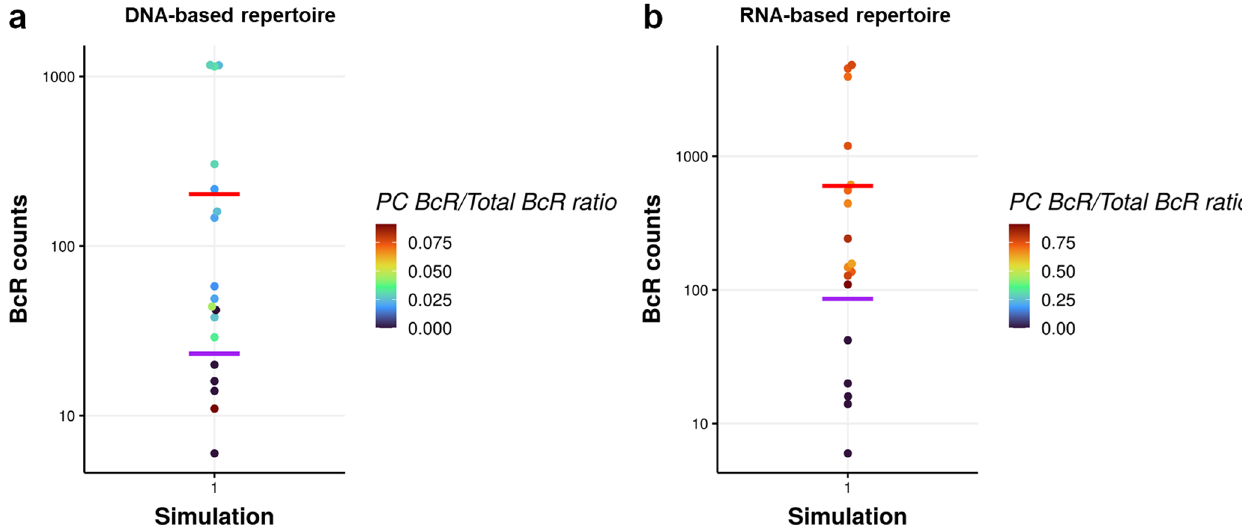
Fig. 9 Beeswarm plots in log10 scale of DNA-seq and RNA repertoires. Beeswarm plots in log10 scale of ( a ) DNA-seq and ( b ) RNA repertoires at day 21 of the GC reaction generated by a representative simulation. Each dot represents a clone, some of which are a mixture of B cells, MBCs and/or PCs. In both cases, we fi nd 5 and 13 dominant clones using the 75th percentile or 0.5% threshold, respectively. Dot colors indicate the fraction of PC BcR sequences within each clone, whose range is about a factor of 100 times larger for the RNA-based repertoire. The size of the symbol represents the median af fi nity of that clone (small symbol: af fi nity below the 75th percentile). The horizontal lines denote the 75th percentile (red) and 0.5% (purple) abundance thresholds to de fi ne dominant